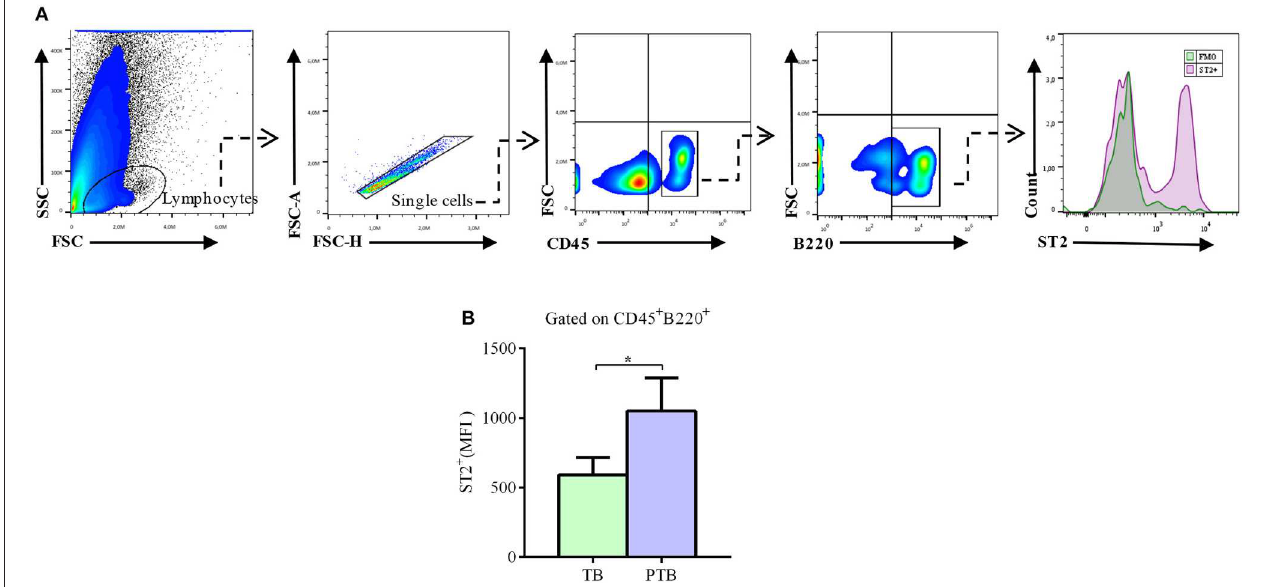
FIGURE 6 | Expression levels of ST2 in decidual B cells during the acute phase of LPS-induced preterm birth. (A) Representative pseudocolor plots and histogram showing gating strategy used to quantify the expression of ST2 in decidual B cells during the acute phase of LPS-induced preterm birth (PTB) and in term birth mice (TB). Lymphocytes were gated by FSC vs. SCC and doublets were eliminated. After gating in total CD45 + leukocytes, B220 was used to identify total decidual B cells. Fluorescence minus one (FMO) was used as control. (B) Bar graph shows median of fluorescence intensity (MFI) for ST2 in decidual B cells from TB ( n = 6) and PTB mice ( n = 6). Data is expressed as mean ± SEM. * p < 0.05 as analyzed by Wilcoxon